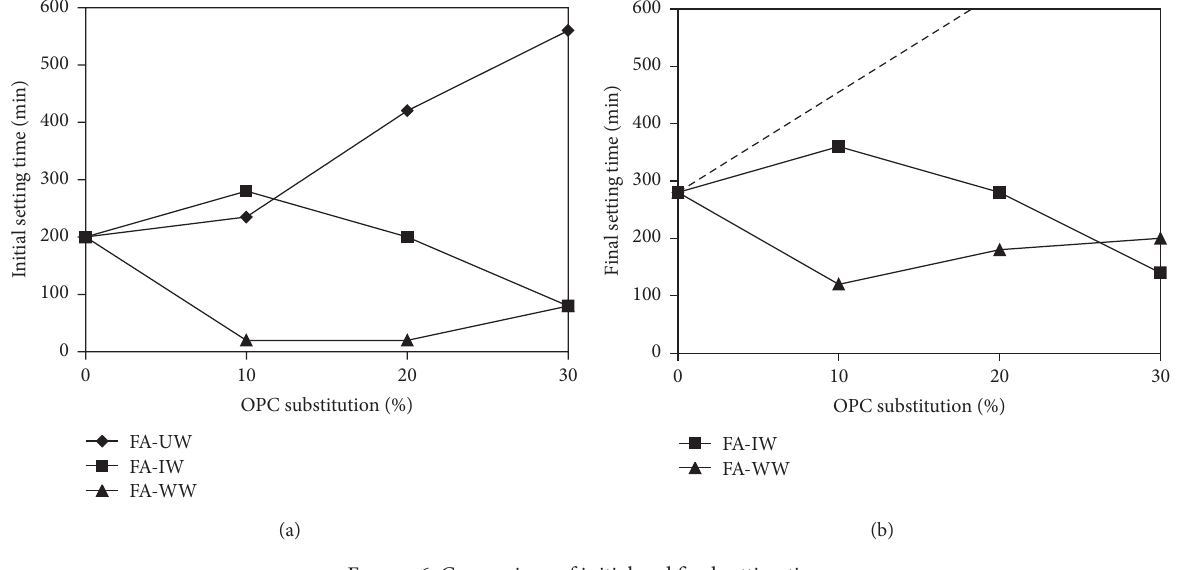
Figure 6: Comparison of initial and final setting time.